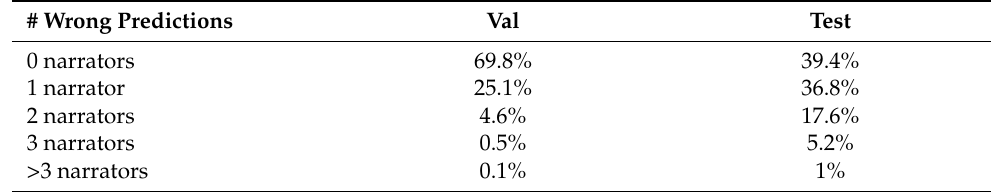
Table 8. Evaluating TunedAraBERT: Percentage of sanad s that have n narrators with wrong predictions.